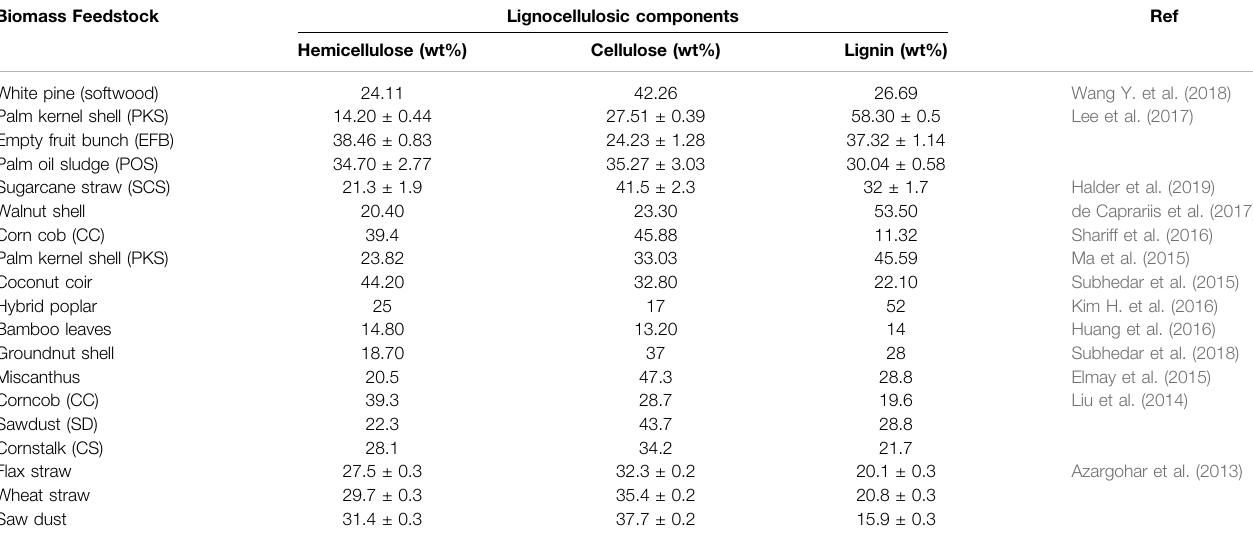
TABLE 2 | Lignocellulosic composition of different residual biomass